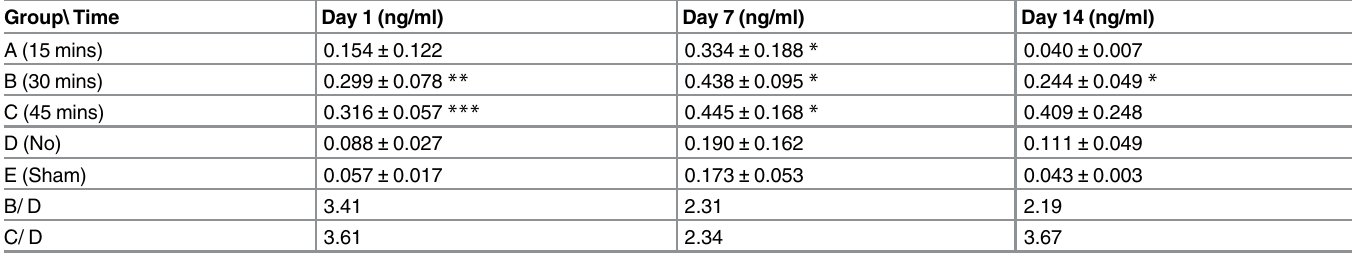
Table 1. tPA level in the peritoneum